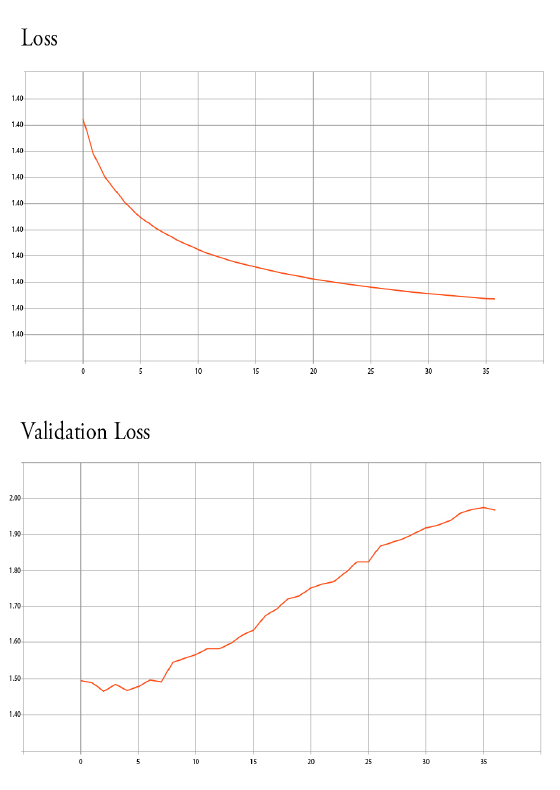
Figure 2. Loss and Validation Loss graphs from Tensorboard